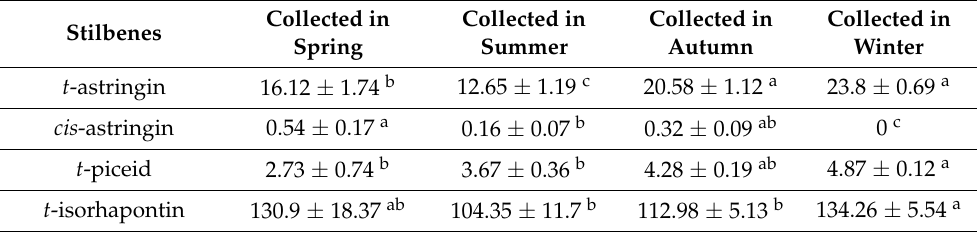
Table 4. Seasonal variations in stilbene content and repertoire in the bark of Picea jezoensis (mg per g of the dry weight (mg/g DW)). Stilbenes were extracted using ethanol for 2 h at 60 ◦ C. Means followed by the same letter (a, b, c, d, ab, bc, or cd) in one row were not different using Student’s t -test (three independent experiments). p < 0.05 was considered statistically